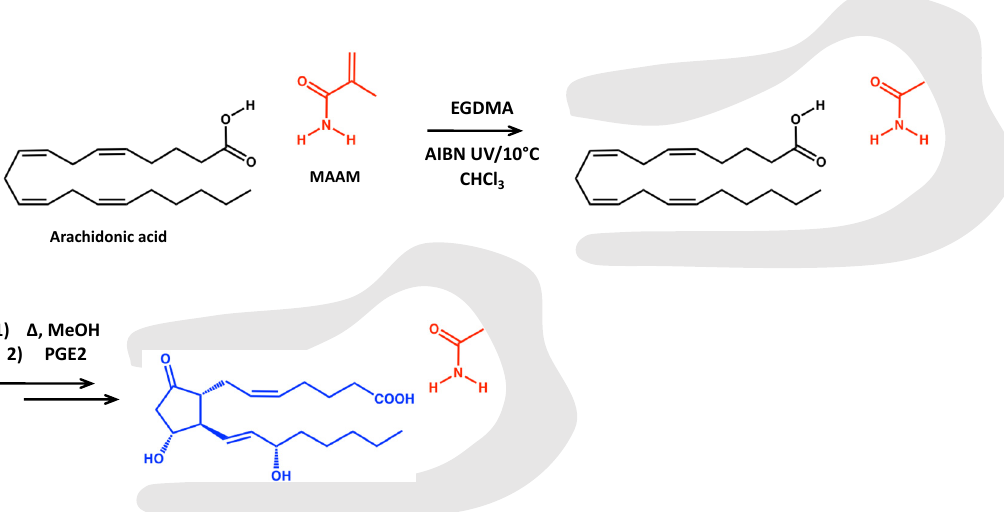
Figure 1. Dummy template imprinting scheme to produce MIPs complementary to prostaglandins. The initial template mol- ecule (arachidonic acid) is represented in black, while the analyte to be bound (PGE2) in the samples is represented in blue.